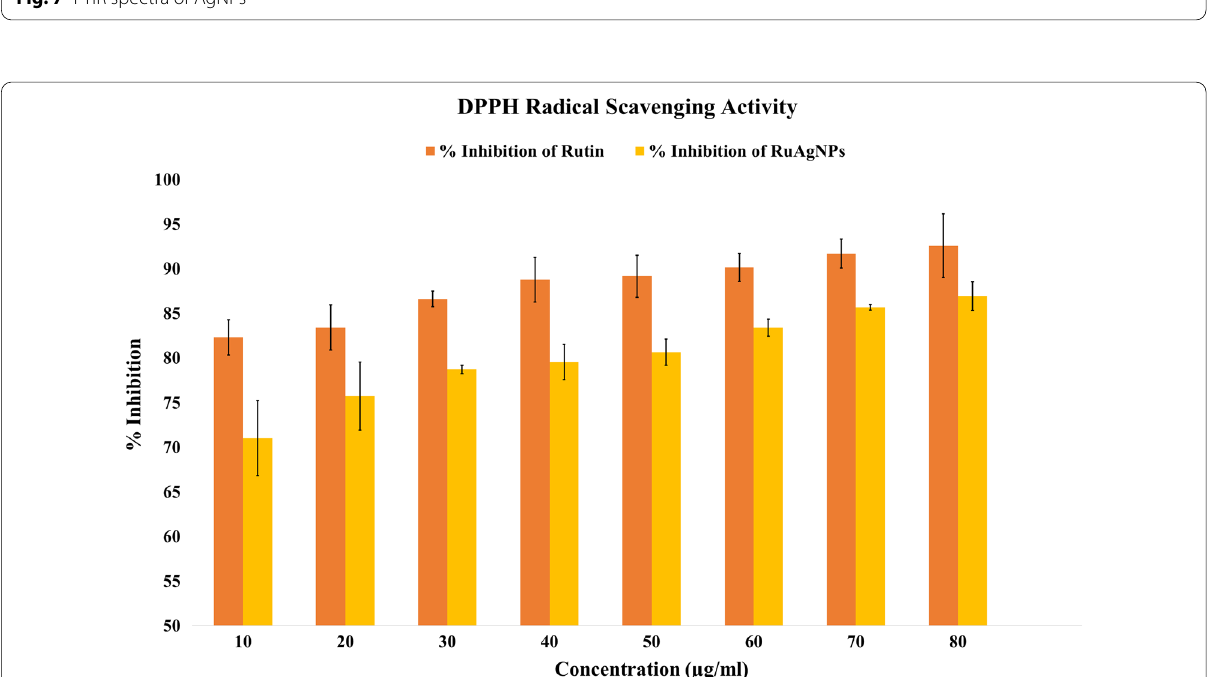
Fig. 8 DPPH radical scavenging activity of rutin and